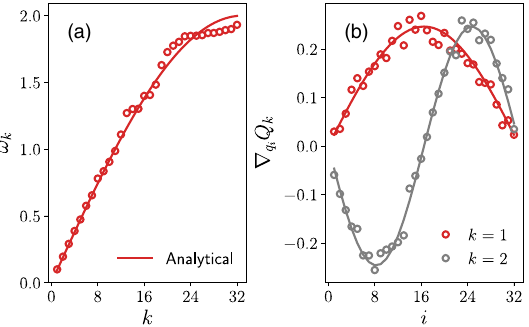
FIG. 4. (a) The learned frequencies of alanine dipeptide pre- Q sented in Sec. IV C from the MD trajectories. The inset shows the k of the two i molecule with slow torsion angles. (b) The mutual information between the few slowest modes and the torsion